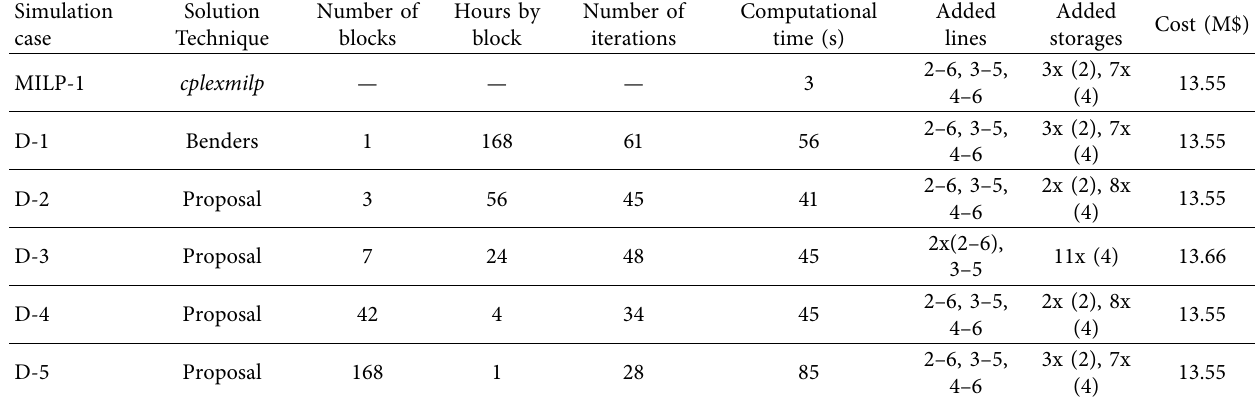
Table 2: Simulation results for the 6-bus modified Garver test system.